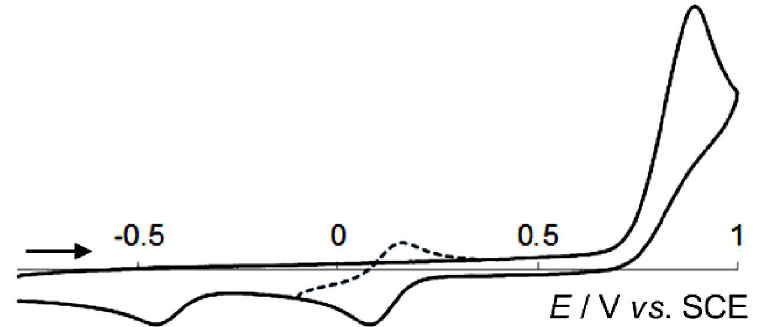
Figure 3. Cyclic voltammogram of DHP 1NO (10 −3 M) in CH Bu NBF , Pt electrode, scan rate 500 mV s −1 ). The reduction peaks are absent when the 4 4 voltammogram is first scanned cathodically. As shown by the dotted line, the first reduction wave at +0.07 V is reversible when the scanning is reversed at −0.10